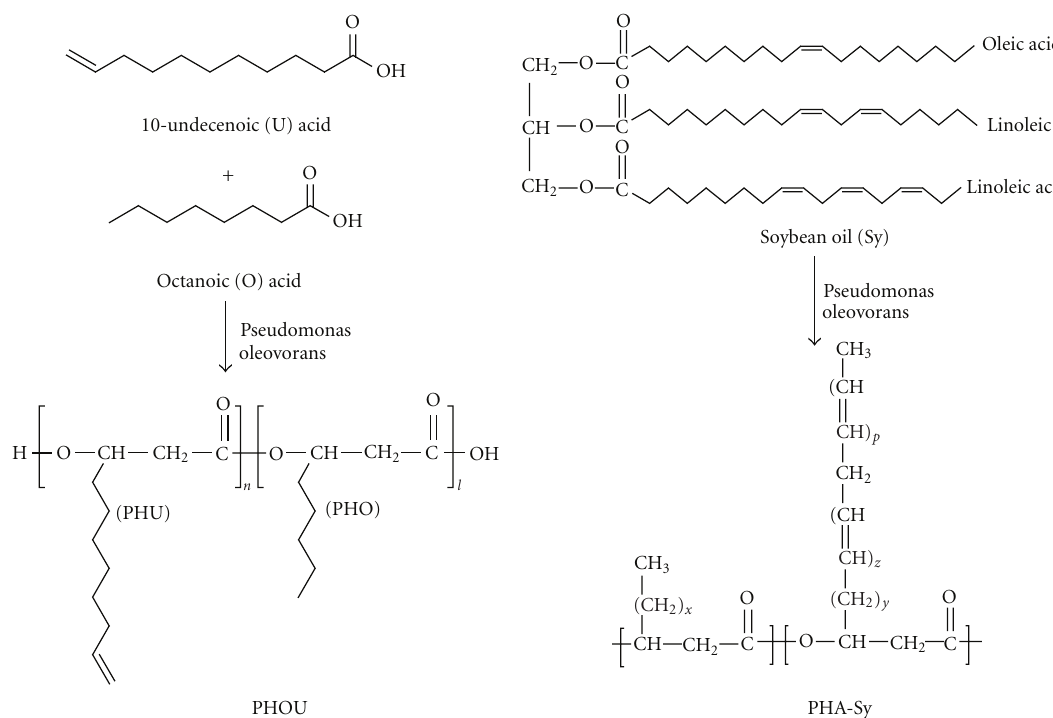
Figure 2: Synthesis of two types of unsaturated PHAs from Pseudomonas oleovorans (i) grown on soybean (PHA-Sy) and (ii) 10-undecenoic acid and octanoic acid (PHOU).